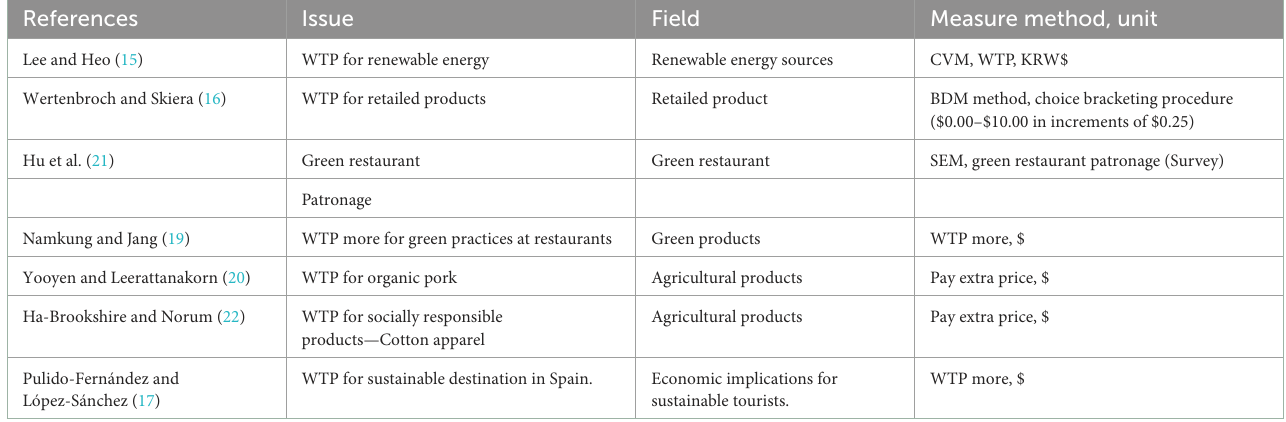
TABLE 1 Major related extant research on